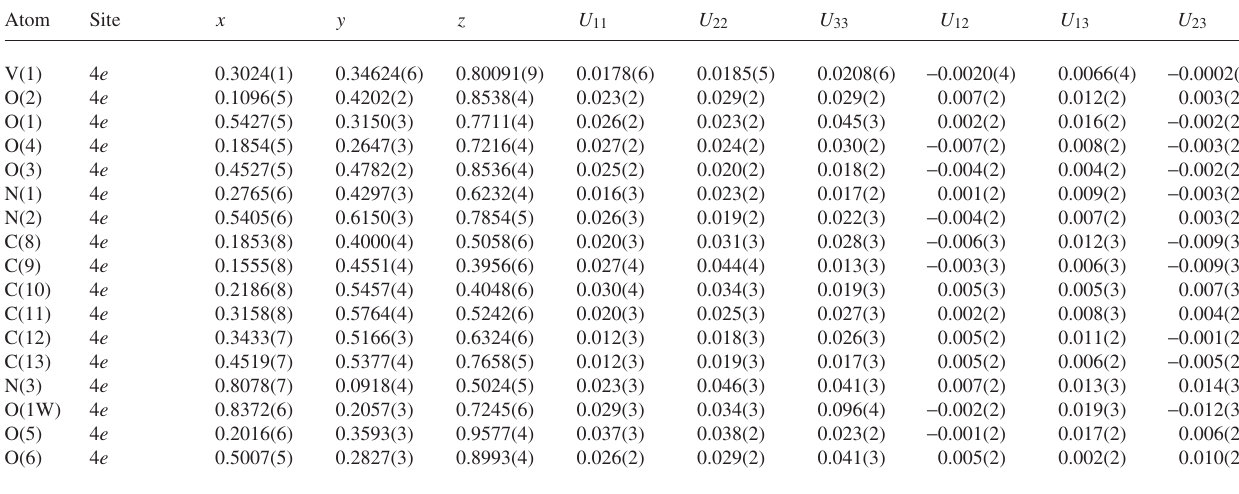
Table 3. Atomic coordinates and displacement parameters (in Å 2 ) .